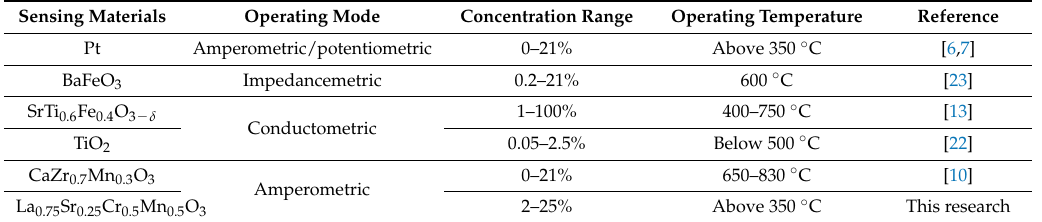
Figure 6. ( a ) Response transient and ( b ) Dependency of the response signal on the oxygen concentration in the range of 2–25% for the sensors comprised of LSCM or Pt electrode; ( c ) Selectivity of the S-LSCM and S-Pt against 5% CO 2 and H 2 O, at the operational temperature of 580 °C. Table 1. Compassion of the sensing behavior for the oxygen sensors using various sensing materials.